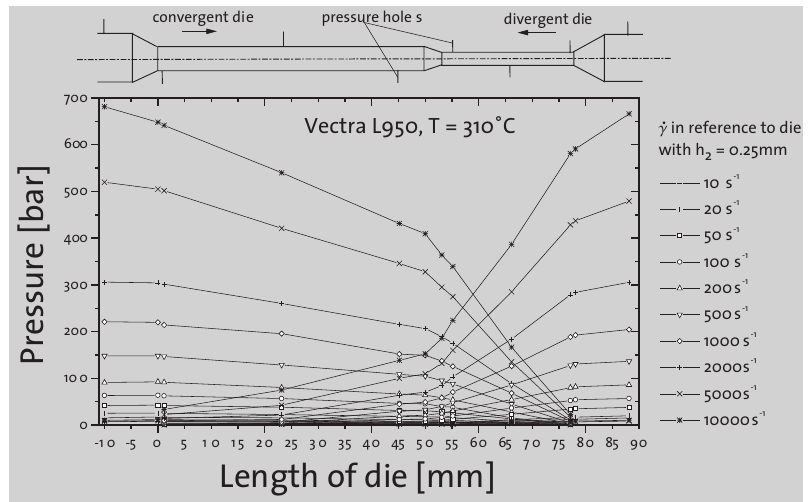
310°C.Figure 4 (above): Pressure profiles measured along the double slit die for convergent and divergent configurations (Material: Vectra L 950 at